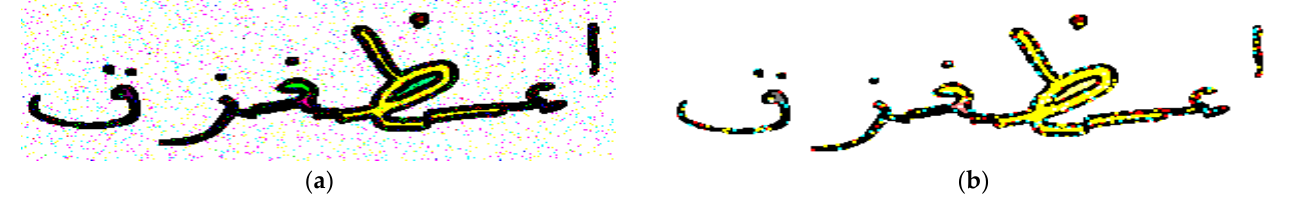
Figure 2. A sample of a normal CAPTCHA and its adversarial version. ( a ) A normal CAPTCHA. ( b ) The adversarial version of ( a ).